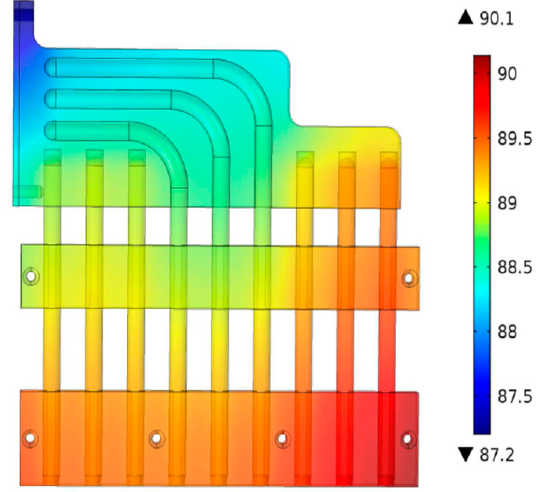
Figure 8. Temperature profile (Type I).